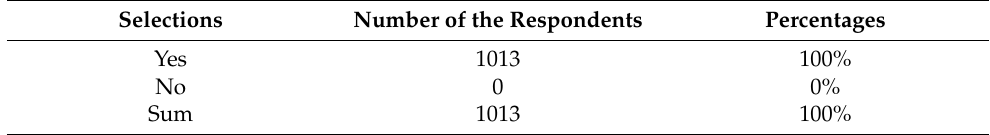
Table A7. Have you already learned Bitcoin (single-choice question)?